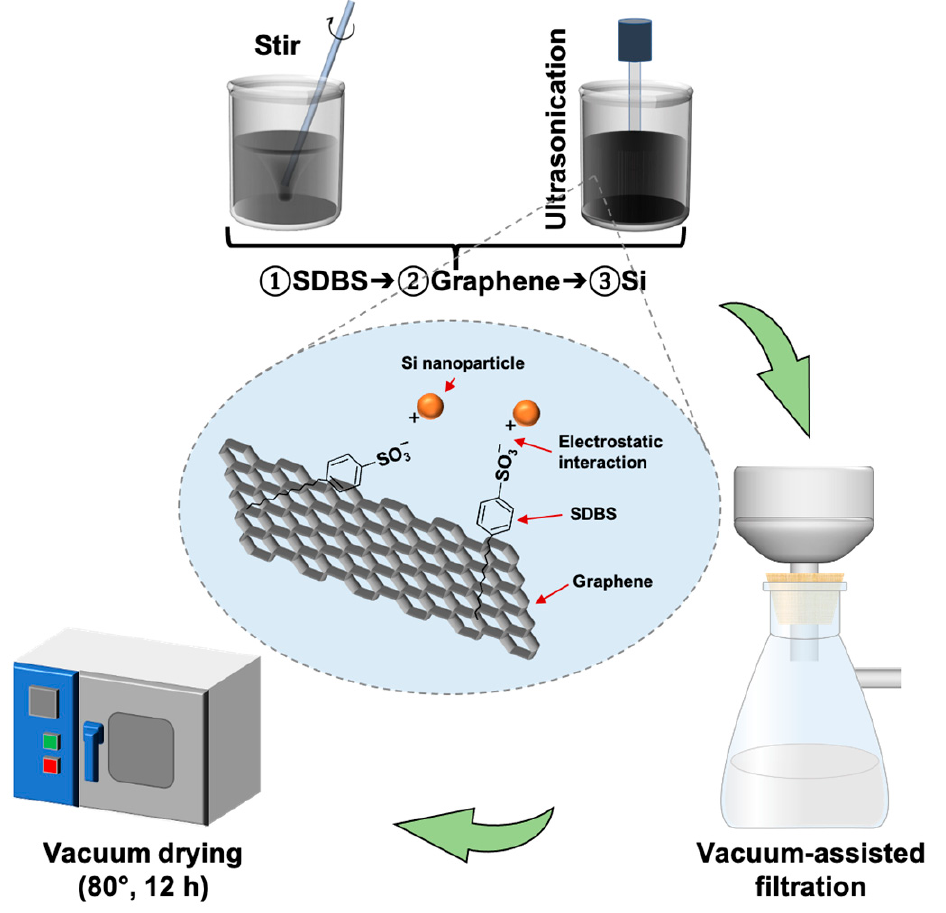
Figure 1. Schematic diagram of the preparation of Si-graphene nanocomposite.